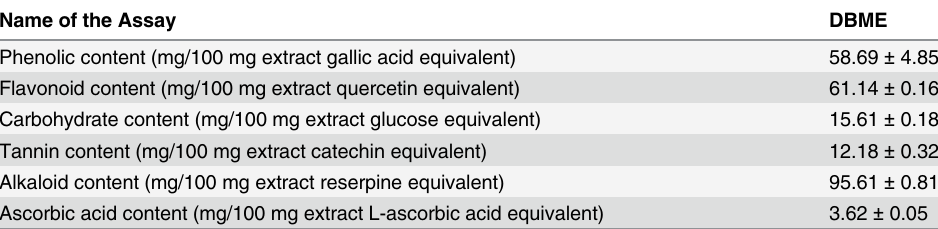
Table 4. Quantification of phytochemicals of